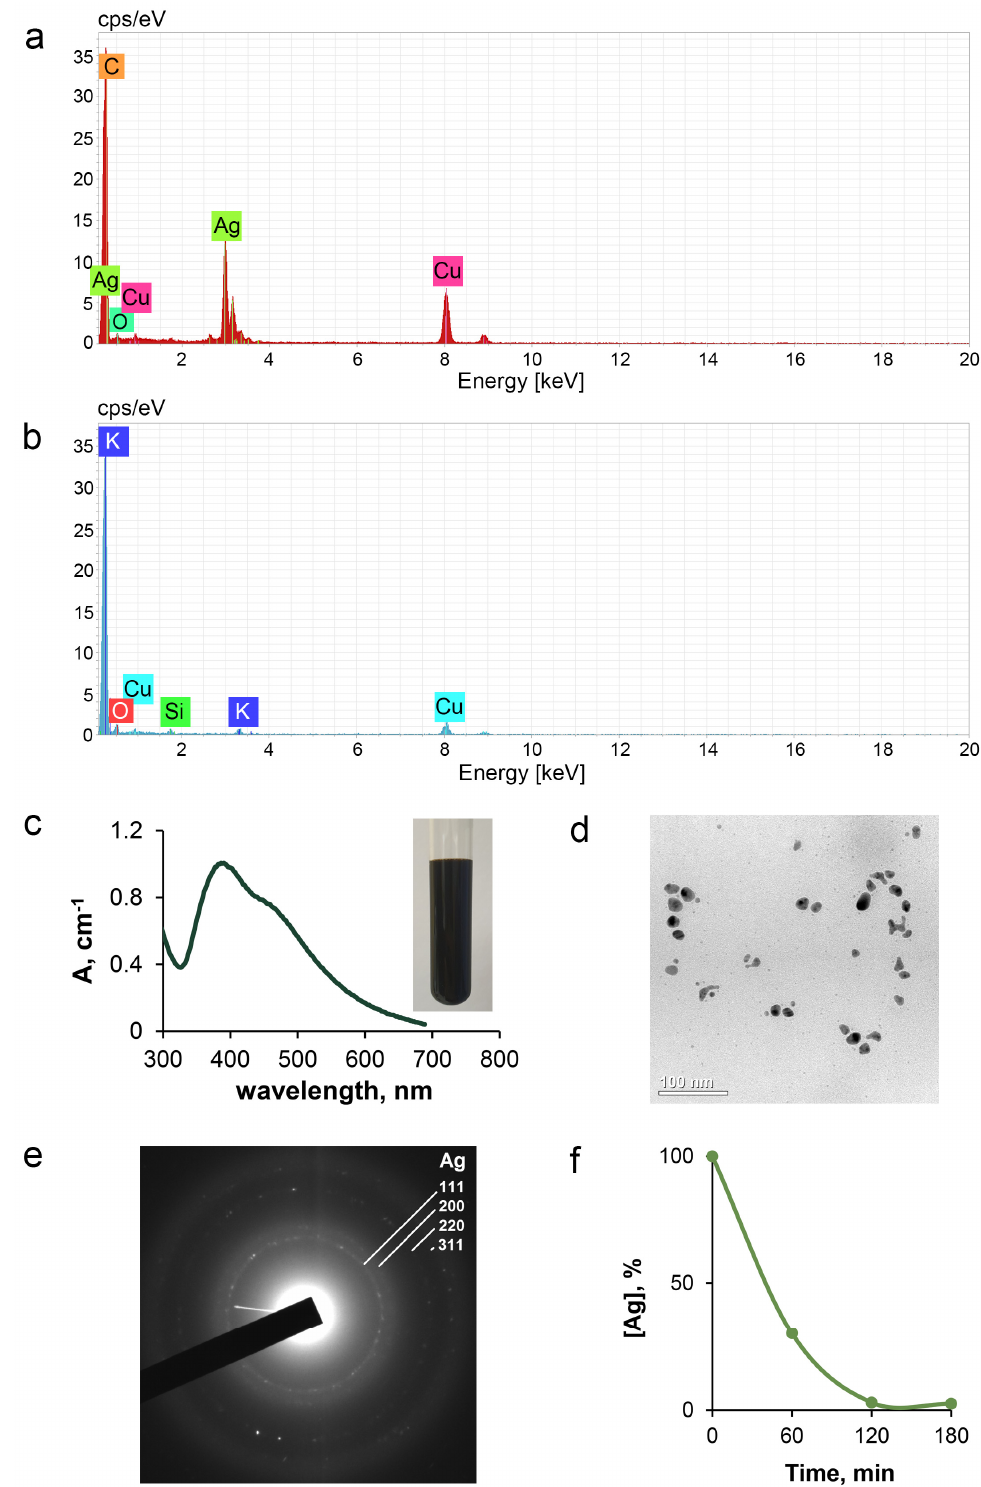
Figure 2. Physicochemical characteristics of fabricated AgNPs. Energy-dispersive X-ray spectrum of ( a ) AgNPs and ( b ) substrate film; ( c ) UV/vis absorption spectra, inset: AgNPs solution; ( d ) Images of the AgNPs obtained by TEM; ( e ) Electron diffraction pattern of the AgNPs; ( f ) Curve of time-dependent sedimentation of nanoparticles. X-axis: centrifuge time, minutes; Y-axis: % of initial silver concentration in the supernatant suspension.